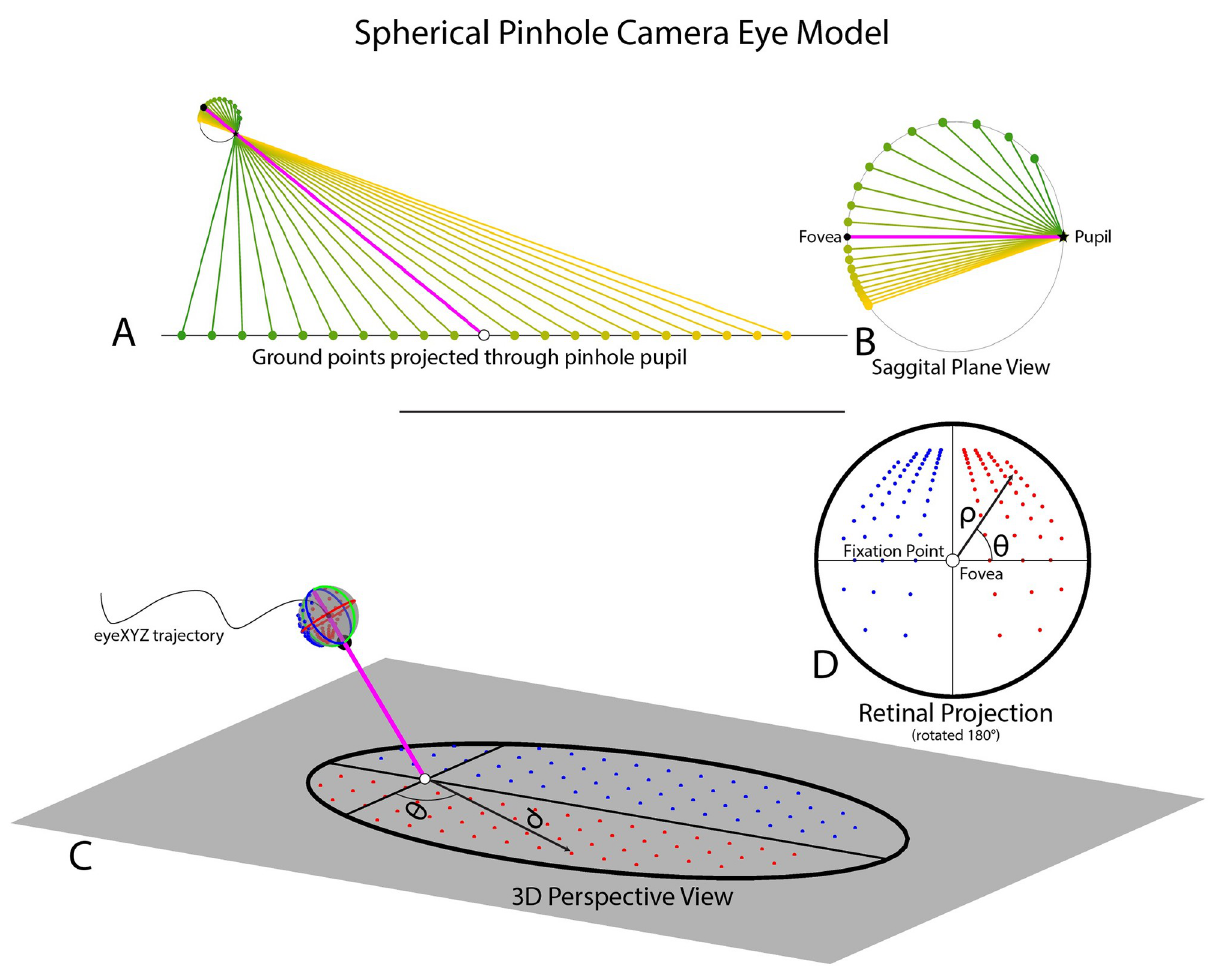
Fig 5. Spherical pinhole camera model of the eye. The spherical pinhole camera model of the eye used to estimate retinal optic flow experienced during natural locomotion. A, B show a sagittal plane slice of the 3D eye model. A shows the eye fixating on a point on the ground (pink line shows gaze vector, black circle shows fixation point) as points in the upper (orange) and lower (green) visual fields project on the back of the eye after passing through a pinhole pupil. B shows a closer view of the sagittal slice of the eye model. C, D show the full 3D spherical pinhole eye model. C shows the 3D eye fixating a point on the ground (black crosshairs), with field of view (60 degree radius) represented by the black outline. Note that the circular field of view of the eye is elongated due to its projection onto the ground plane. Red and blue dots represent points in the right and left visual field, respectively. D shows the retinal projection of the ground points from C on the spherical eye model. Ground dot location in retinal projection is defined in polar coordinates ( ϑ , ρ ) relative to the fovea at (0,0), with ϑ defined by the angle between that dot’s position on the spherical eye and the ‘equator’ on the transverse plane of the eye (blue circle) and ρ defined as the great-circle (orthodromic) distance between that dot and the fovea of the spherical eye. The retinal projection has been rotated by 180 degrees so that the upper visual field is at the top of the image.